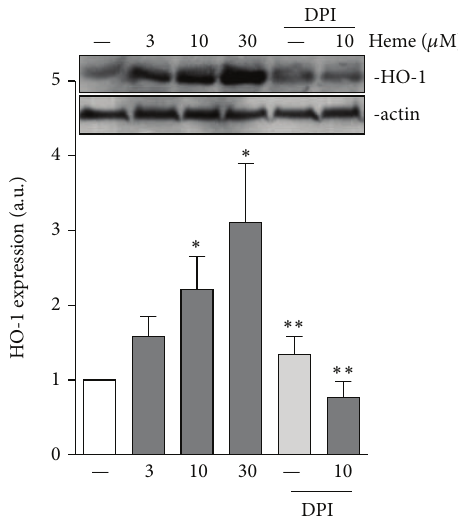
Figure 5: Heme-induced HO-1 expression is NADPH dependent. Rat AMs (1 × 10 6 /mL) were pretreated with DPI (10 𝜇 M) followed by incubation in the absence or presence of heme (10 𝜇 M) for 24 h. Incubations were terminated by the addition of lysis buffer and lysates were subjected to immunoblotting with anti-HO-1 and anti-actin antibodies. Results are demonstrated as the HO-1/actin ratio. The data shown are representative of three independent experiments. The mean ± S.D. is presented. ∗ 𝑃 < 0.05 when compared with controls. ∗∗ 𝑃 < 0.05 when compared to cells treated with